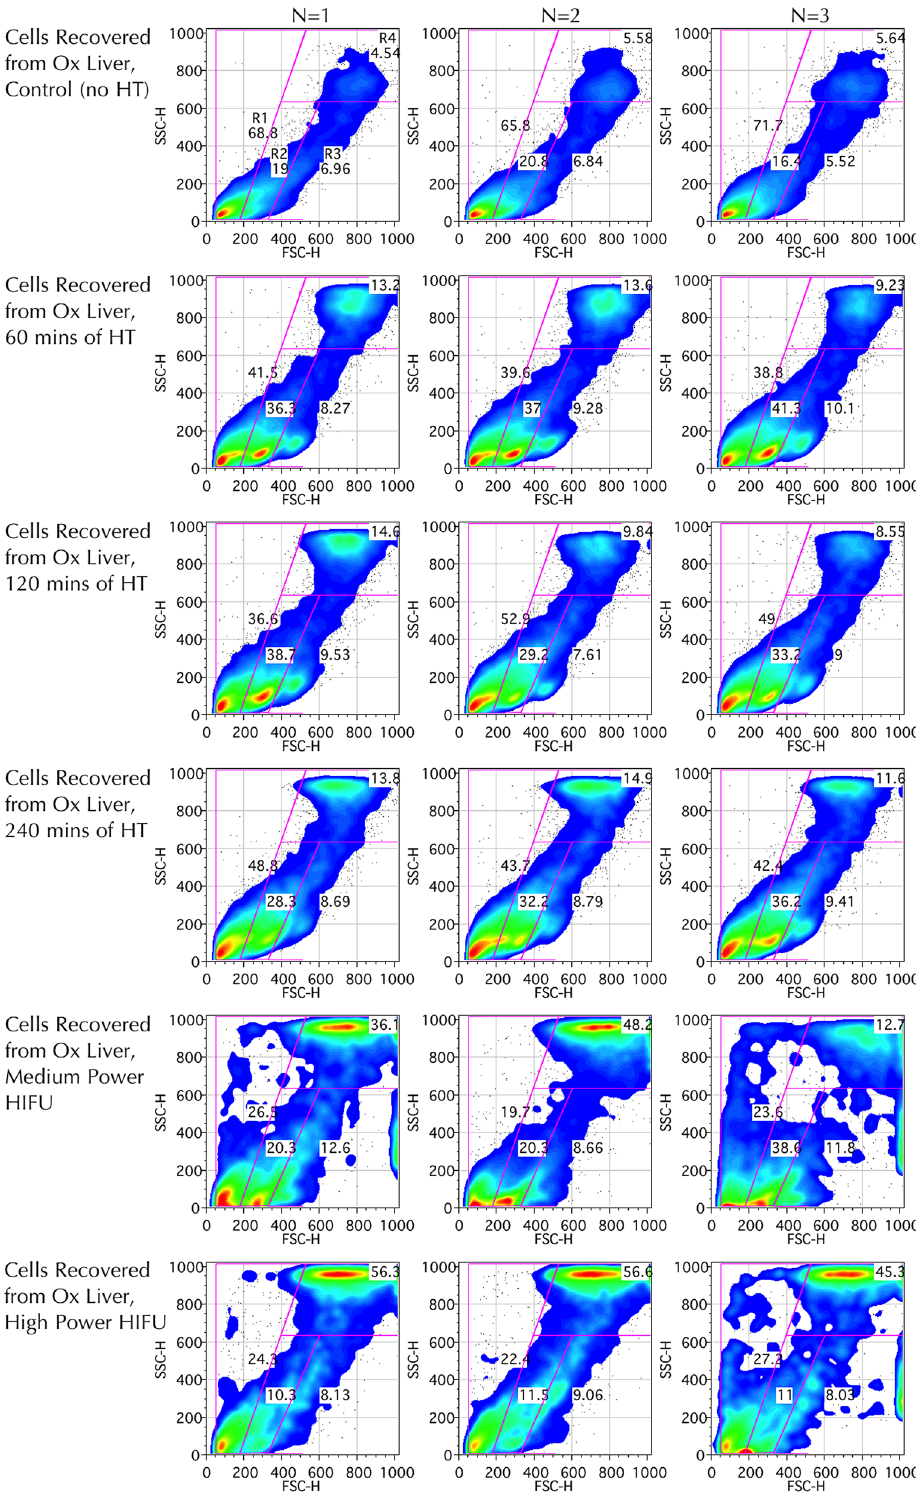
Figure 8. SSC and FSC flow cytometric studies of cells recovered from control liver and liver exposed to varying durations of hyperthermia and powers of HIFU (N = 3, Columns). Representative plots for 0, 60, 120 and 240-min of hyperthermia (rows 1–4) and medium (7.27 MPa) and high (8.19 MPa) HIFU powers (rows 5–6) shown. Sub-populations have been gated, with gates labelled in top-left plot only. Plots demonstrate a trend for at first increased FSC (moving from R1 to R2), followed by dramatically increased SSC and FSC (cells moving from R1/R2 populations to R4) with increasing severity of hyperthermic or ablative insults, consequent with larger cell size and granularity. Events with FSC < 70 discarded. Plots generated using FlowJo Data Analysis